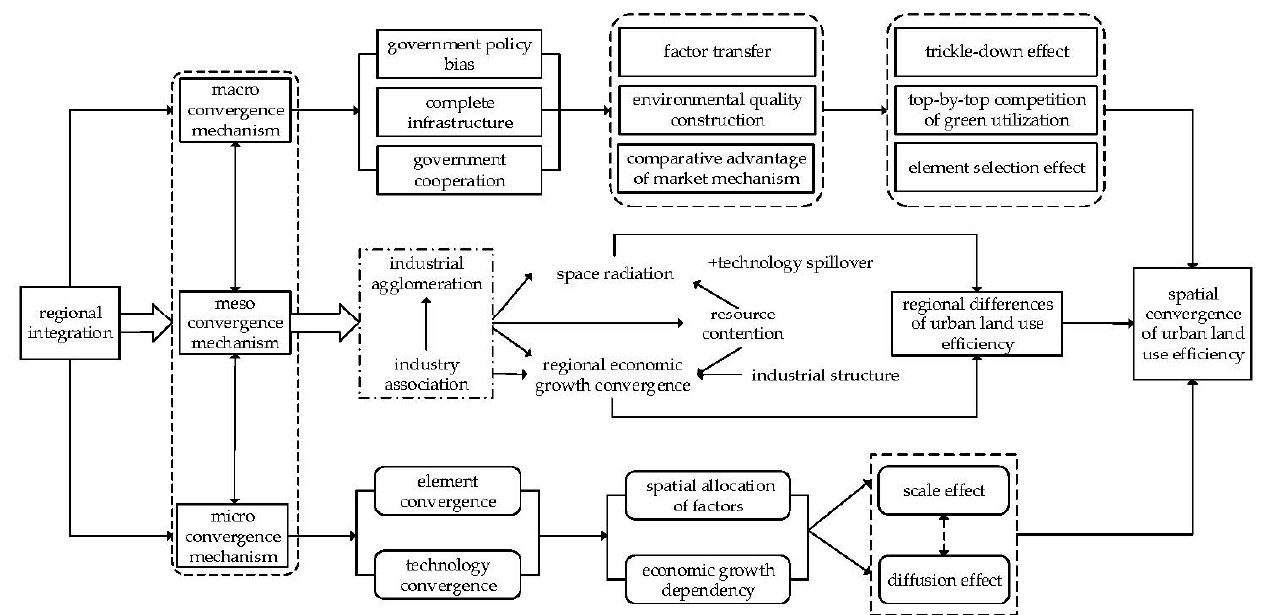
Figure 1. Spatial convergence mechanism of ULUE under the background of regional integration.